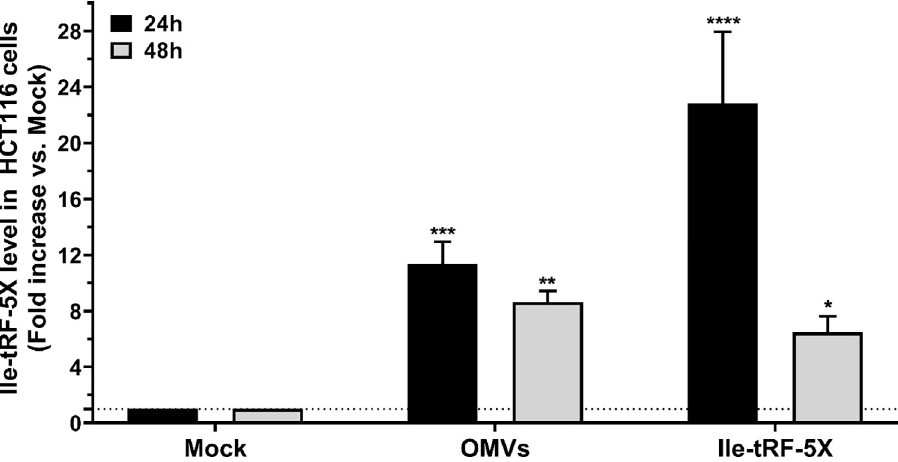
Fig 6. Bacterial OMVs deliver Ile-tRF-5X to human HCT116 cells. Human HCT116 cells were incubated with (10 ng) E . coli MG1655-derived OMVs or transfected with an equivalent amount of synthetic Ile-tRF-5X. The level of Ile- tRF-5X was measured at 24 h and 48 h by LNA RT-qPCR. UniSp6 was used as spike-in control and reference gene for normalization. The results were reported in fold change compared to the corresponding mock condition.